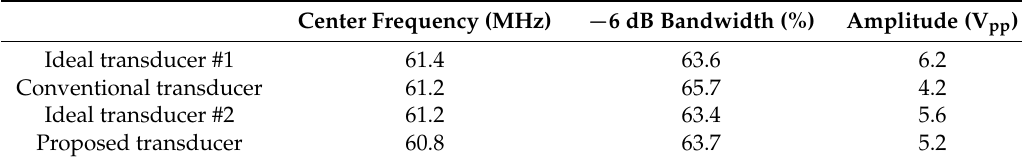
Figure 4. Simulated pulse-echo results of four transducers: ( a ) Ideal transducer #1; ( b ) conventional transducer; ( c ) ideal transducer #2; and ( d ) proposed transducer. The solid line indicates the time-domain response and the dashed line is the frequency-domain response. Table 5. Simulated pulse-echo test results.